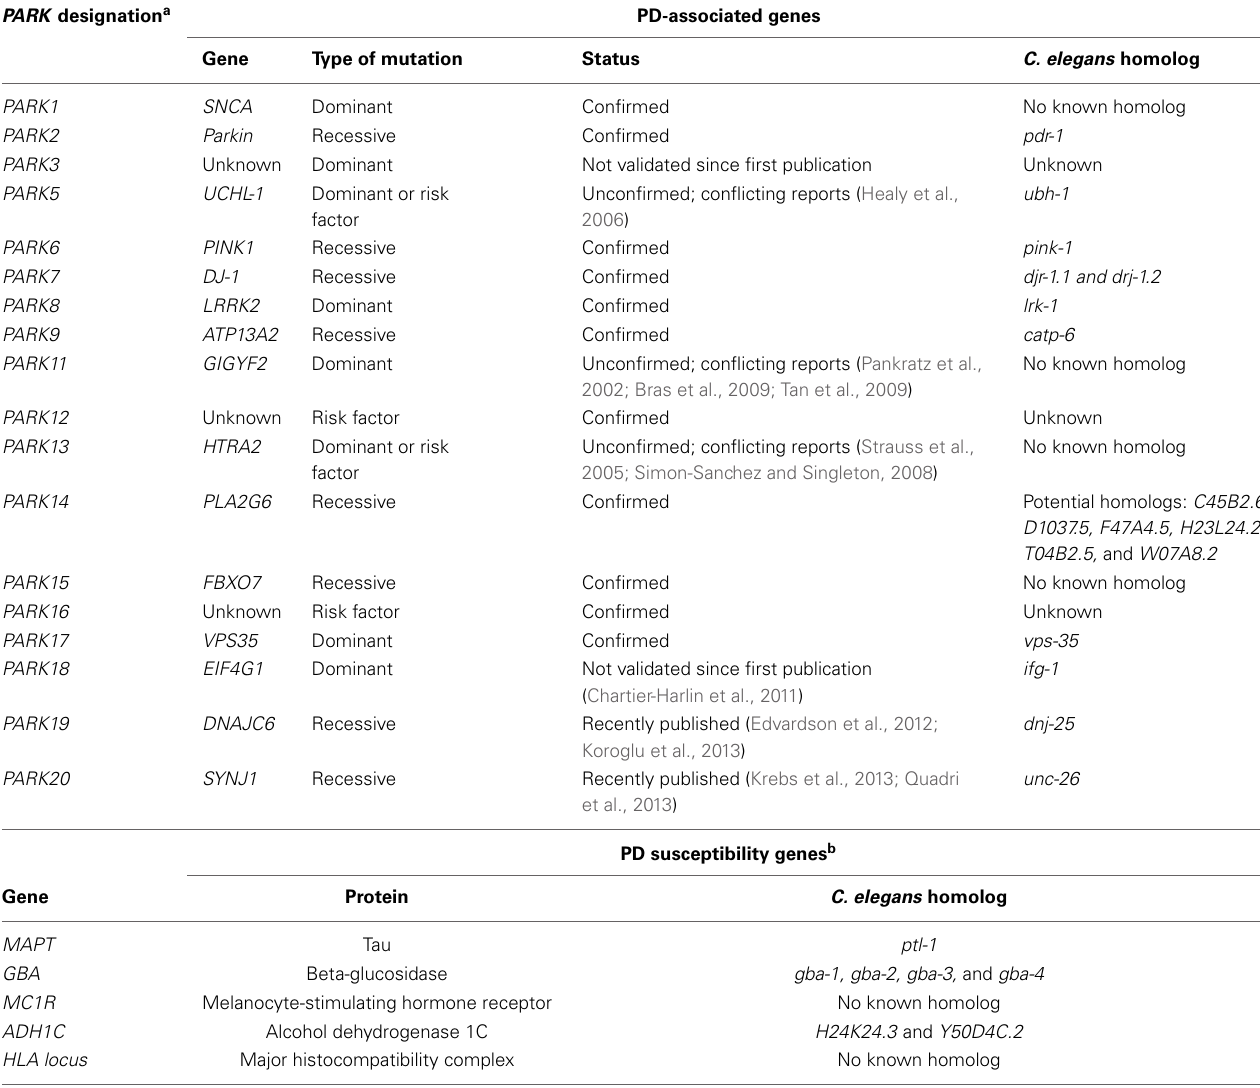
Table 1 | PD associated and susceptibility genes and corresponding C. elegans